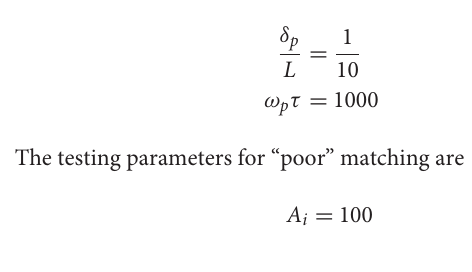
[ 96,96] is modeled with the ∈ −